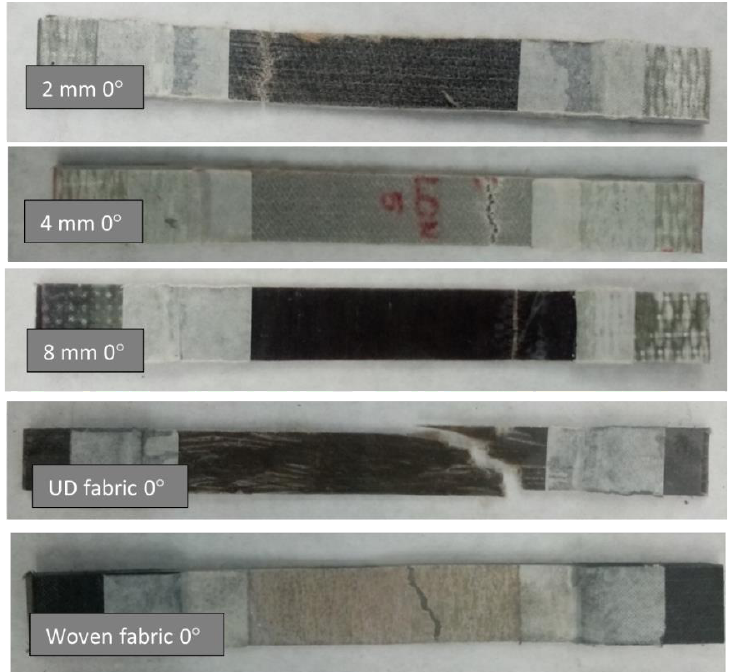
Figure 8. Samples of 0° variant after the break.